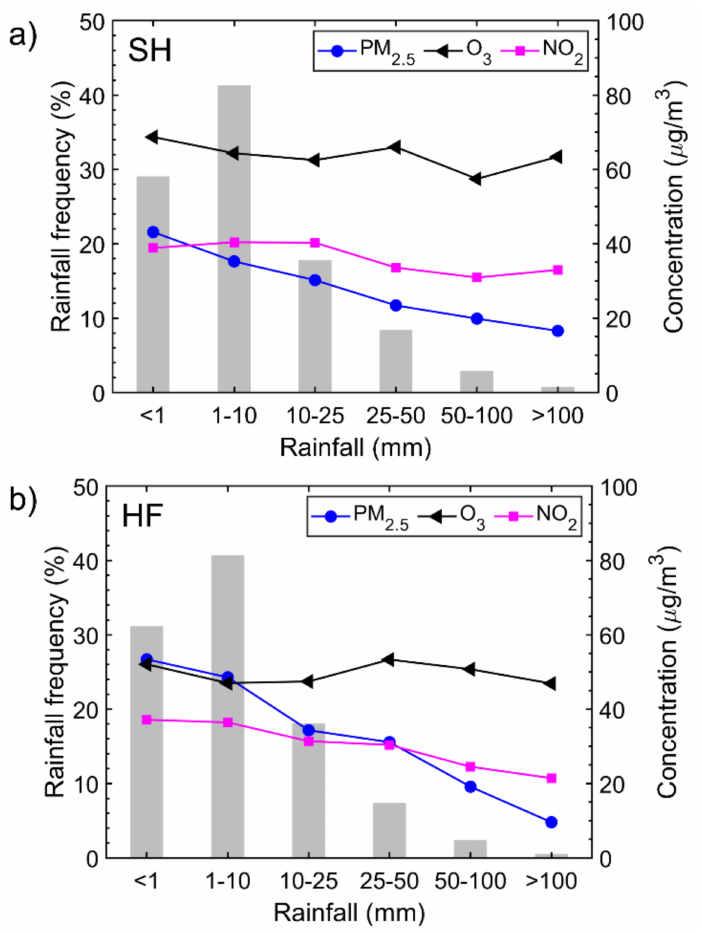
Figure 6. Daily rainfall frequency statistics (gray bars) and average concentrations of PM 2.5 , O 3 , and NO 2 (colored curves) for each rainfall intensity category in ( a ) Shanghai (SH) and ( b ) Hefei